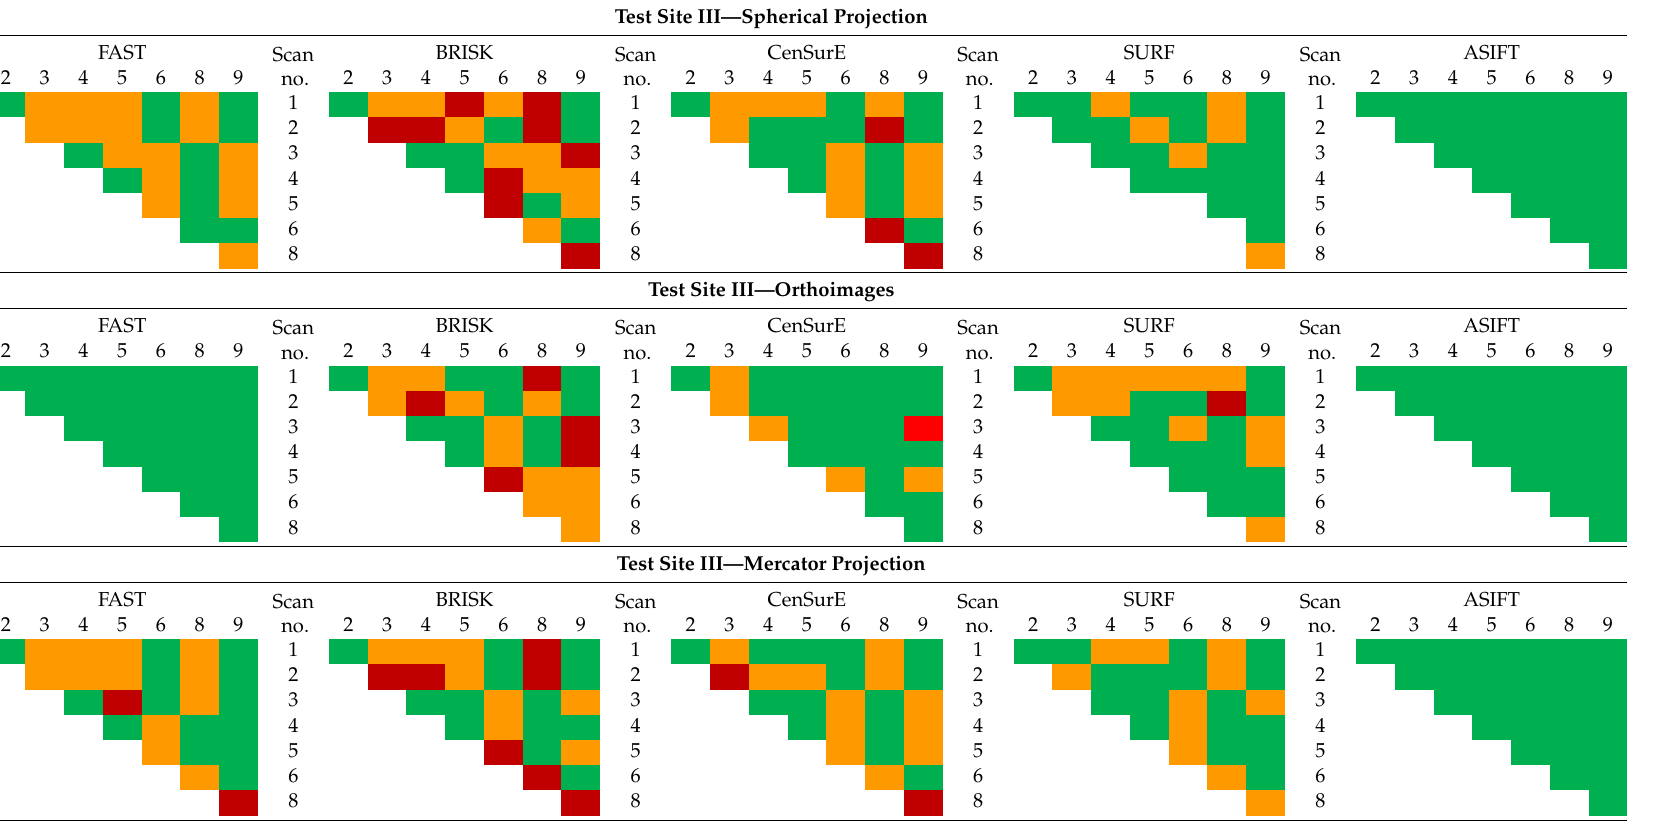
Table 4. The accuracy of the automated connecting of scans for Test Site III (both scenarios): green, correct matching (full registration); orange, preliminary orientation requiring the final registration using the ICP method; and red, no matching.